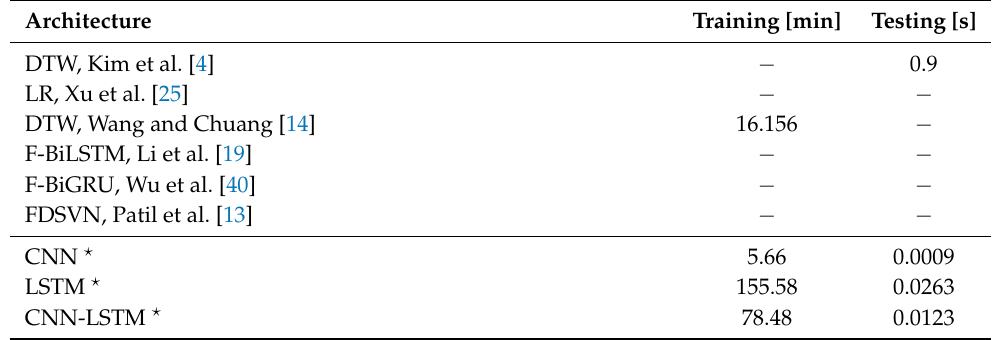
Table 6. Elapsed time expended in training (in min) and testing (in